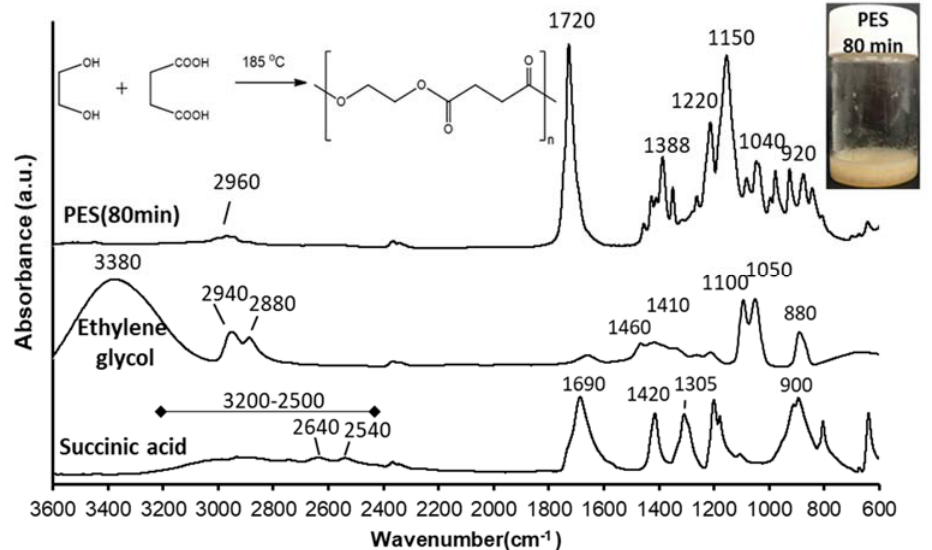
Figure 1. FTIR spectra of succinic acid and ethylene glycol monomers as well as the synthesized polyester sample (after 80 min polycondensation time). The inserted scheme shows the synthesis of PES by condensation reaction between ethylene glycol and succinic acid.